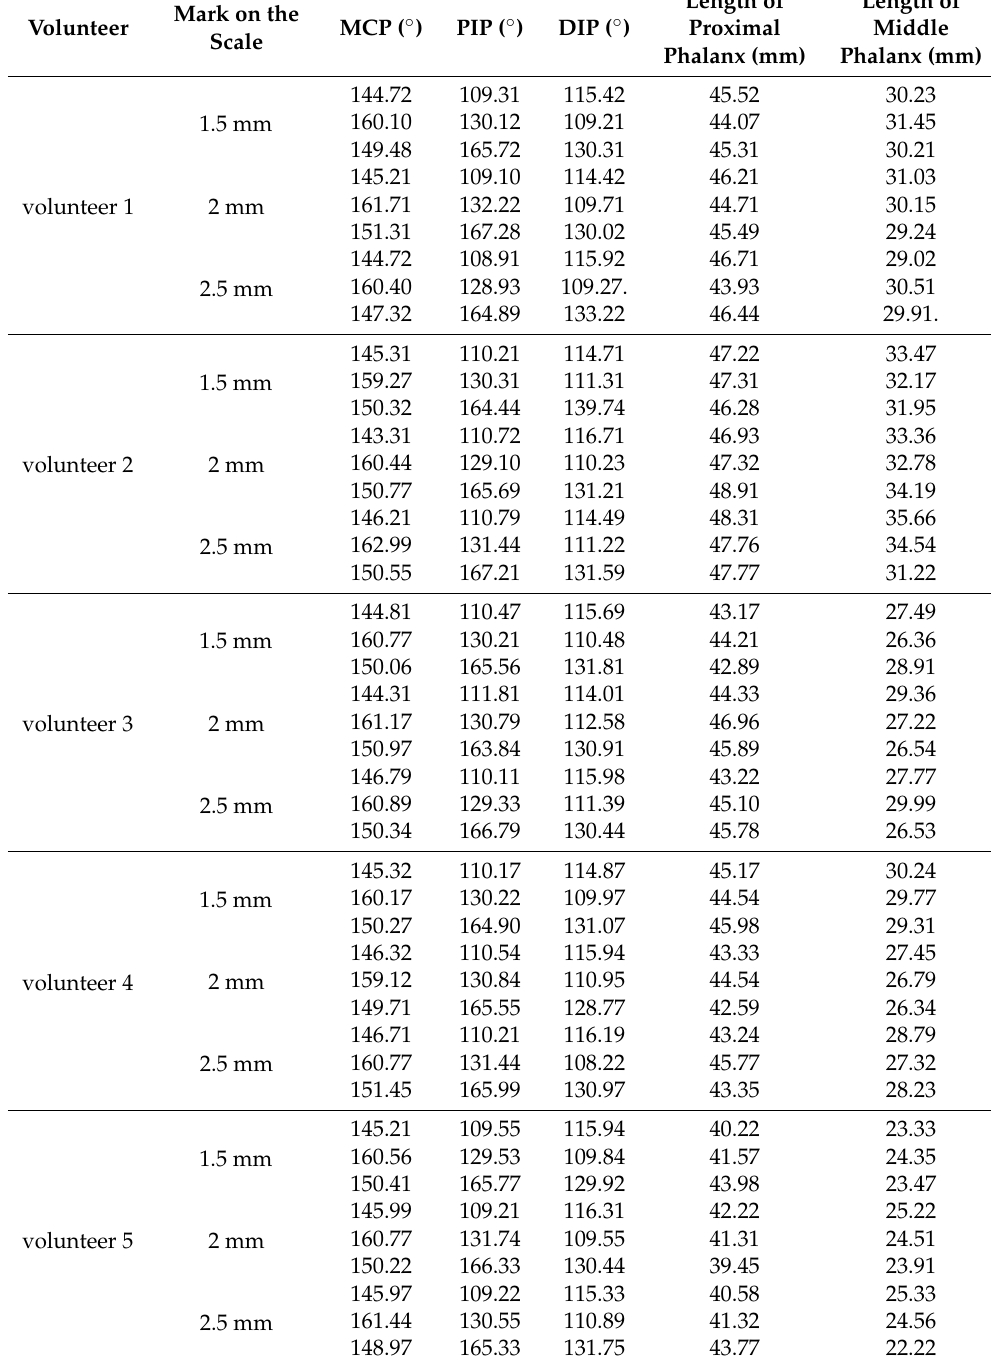
Table 3. Results of different volunteers’ visual-detection